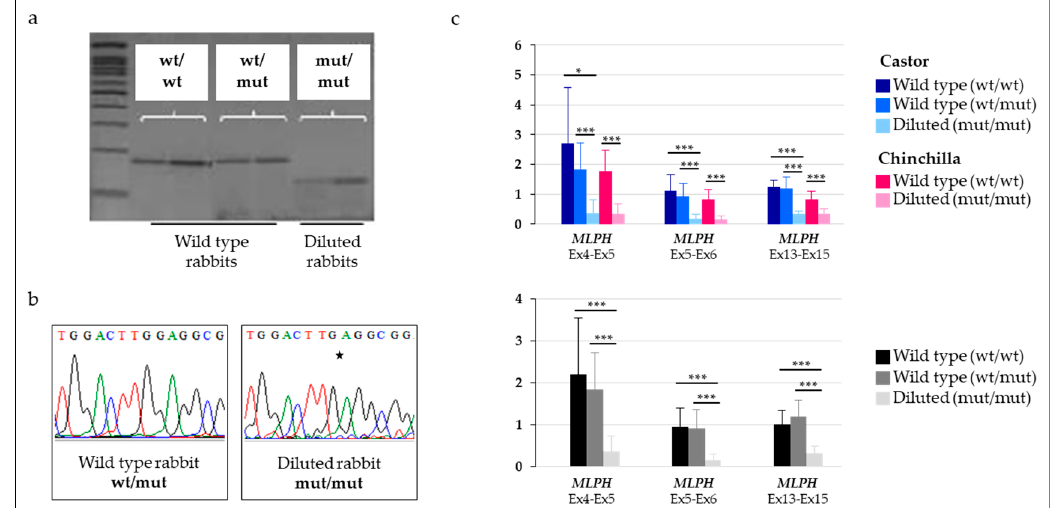
Figure 4. Accumulation and stability of MLPH transcripts in skin samples of rabbits with either wild type or dilution phenotype. ( a ) Semiquantitative analysis of MLPH transcripts by cDNA Restriction Fragment Length Polymorphism (RFLP) for the c.585delG variant in wild type and diluted rabbits. In wild type animals which are heterozygous, the deleted MLPH transcript was not observed. ( b ) Sequencing of cDNA. Two rabbits (1 wt vs. 1 diluted) that are, respectively, heterozygous and homozygous for the mutant allele at the c.585delG variant were sequenced. In the heterozygous animal, only the wild type MLPH transcript without the deletion was detected. ( c ) Quantification of the MLPH expression. At the top, Castor animals are in blue (dark, medium and light, respectively, for wt/wt, wt/mut and mut/mut at the c.585delG variant position) and Chinchilla rabbits are in pink (dark and light, respectively, for wt/wt and mut/mut at the c.585delG variant position). At the bottom, previous results were combined to compare animals given their genotype at the c.585delG variant position. Stars correspond to the significance from the performed t ‐ test, where * is p < 0.05 and *** is p < 0.001.